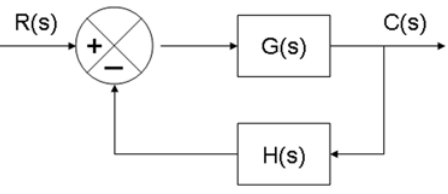
Figure 6. Scheme of a SISO system